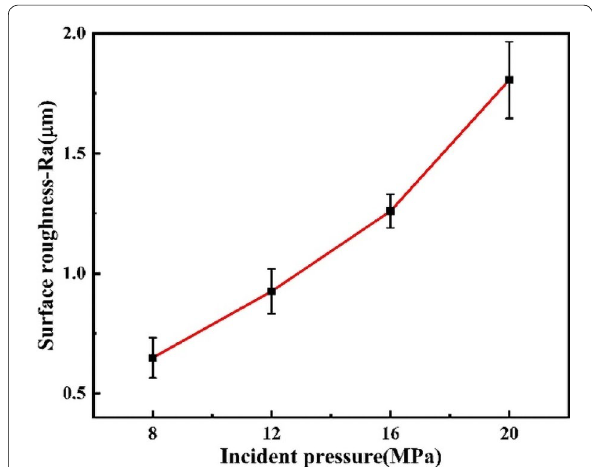
Figure 12 Surface roughness of center area of bulging parts under different incident pressures